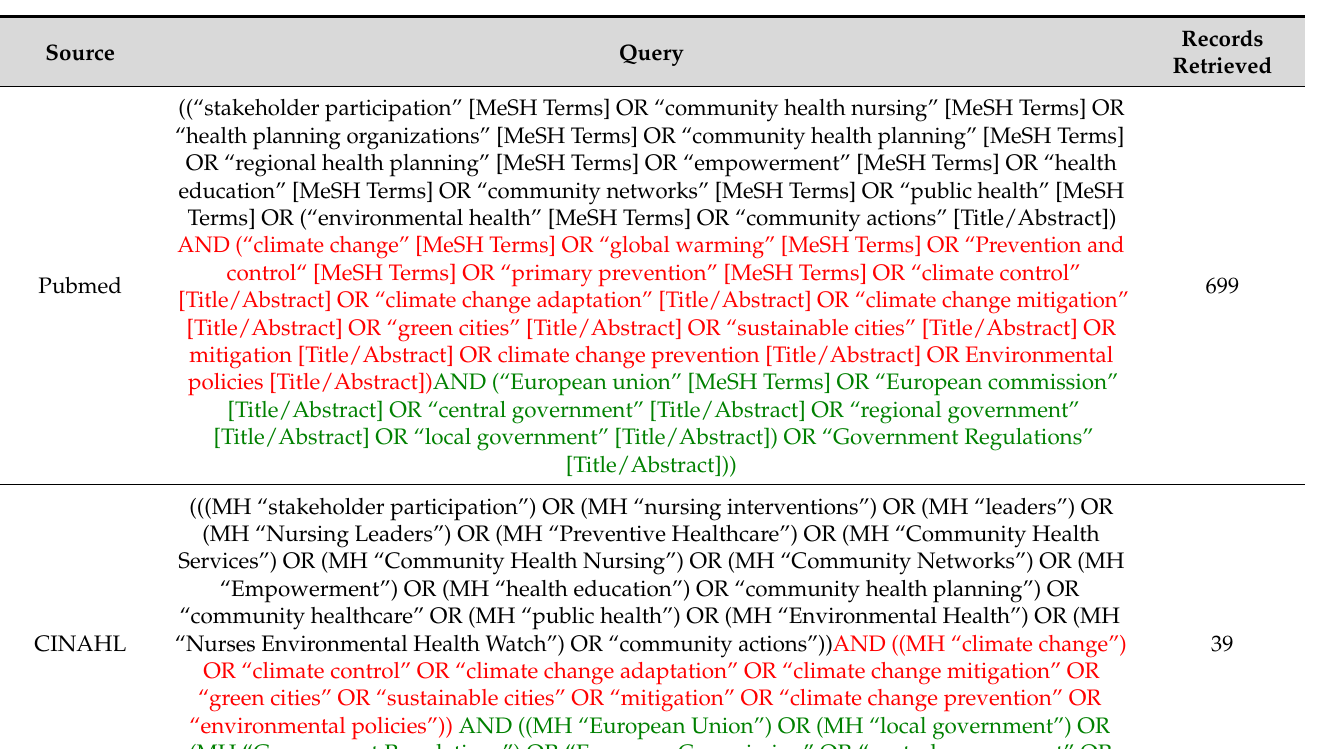
Table A2. Search Strategy. Searches conducted from 1 January 2005, 7 March